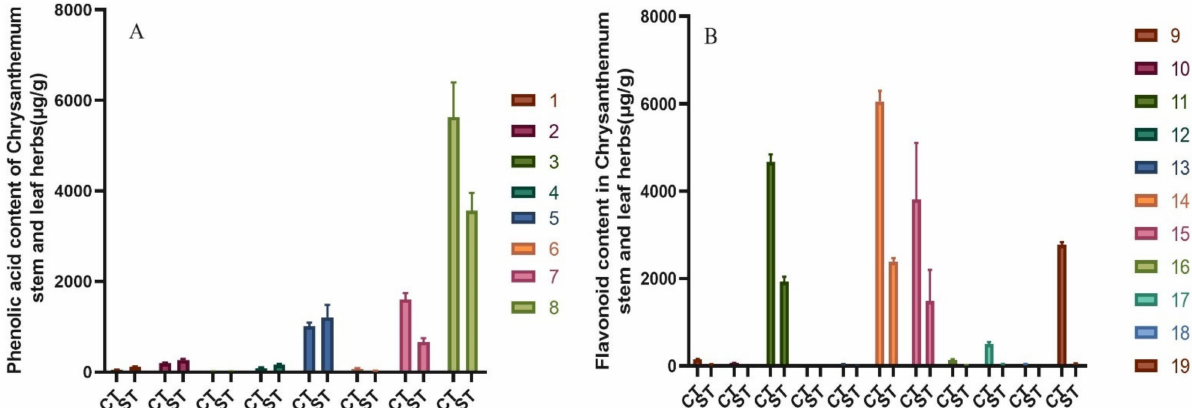
Figure 6. Contents of total phenolic acids and total flavonoids in alcohol extract from chrysanthemum stem and leaf (CT) and water extract from chrysanthemum stem and leaf (ST) of chrysanthemum stem and leaf. ( n = 10). ( A ) Comparison graph of phenolic acid content in the extract; ( B ) Comparison graph of flavonoid content in the extract. According to the peak order, the components are